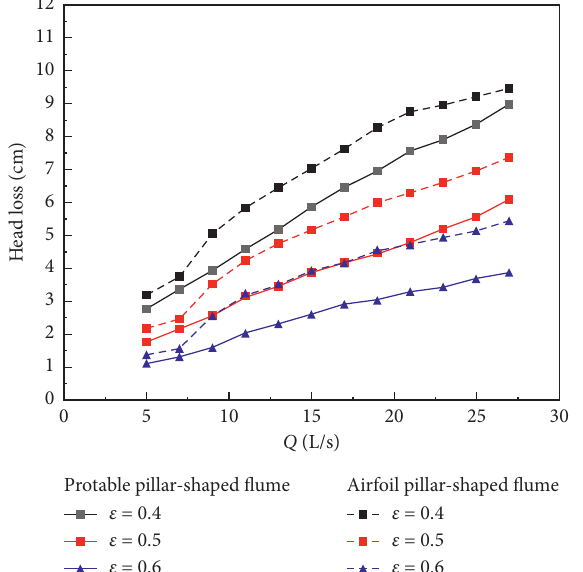
Figure 13: Relationship between the percentage of head loss and flow rate at different contraction